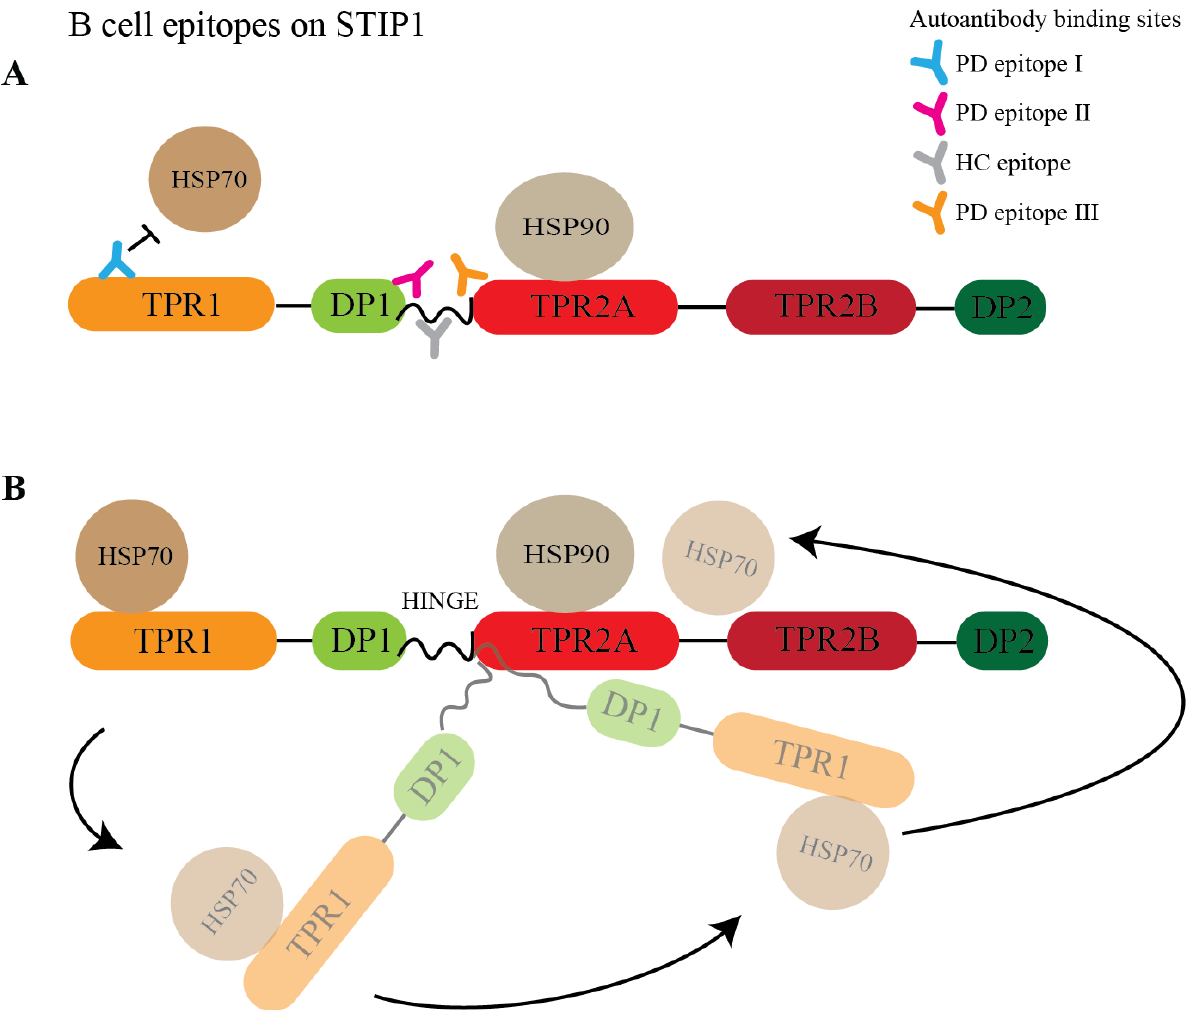
Figure 6. Model of the STIP1 autoantibodies disrupting the chaperone machinery. ( A ) STIP1 autoan- tibodies targeting various domains are shown. Parkinson’s disease antibodies recognise peptide 2 (PD epitope I), 38 (PD epitope II), and 42/43 (PD epitope III) while healthy control-specific antibodies target peptides 40/41 (HC epitope). The presence of autoantibodies will disrupt the association of HSP70s with TPR1 and ( B ) impede the function of the flexible hinge that is crucial for the HSP70s’ interdomain movement from TPR1 to TPR2B. This movement allows HSP70 to be in close proximity to HSP90 for client transfer and